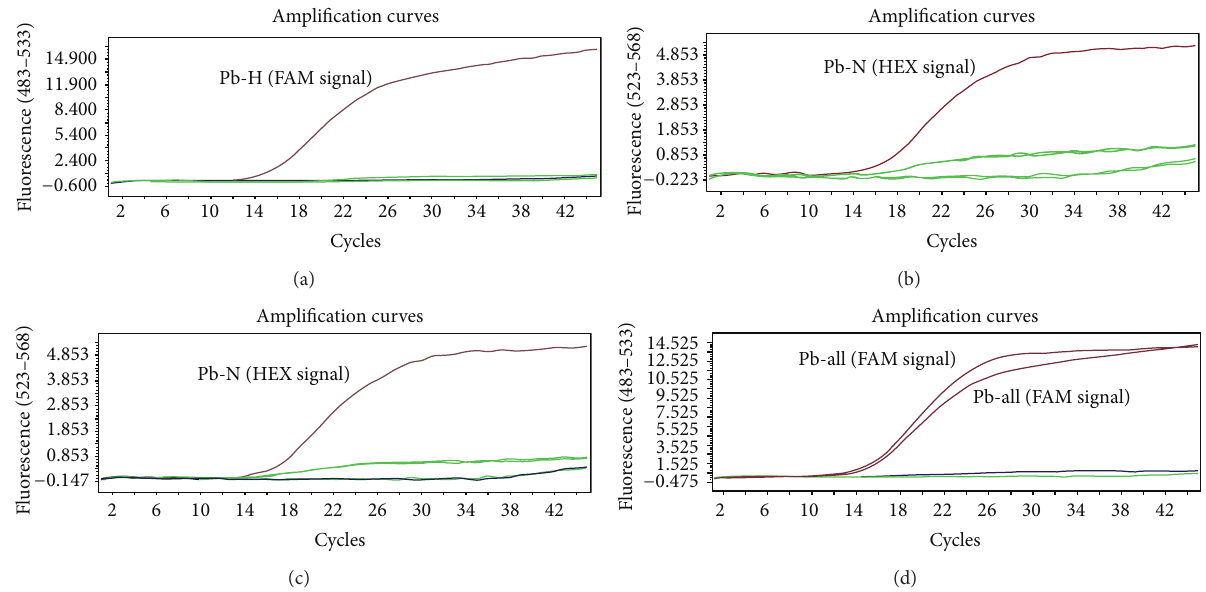
Figure 4: Specific amplification curves by duplex TaqMan probe real-time PCR. When Pb-H (FAM) and Pb-N (HEX) probes were combined in a duplex real-time PCR system, only the FAM fluorescent signal could be observed when the template was GD HP-PRRSV strain, no FAM signal was detected when the templates were CH-1a PRRSV strain and other viruses (a), and vice versa, only the HEX signal could be collected when the template was CH-1a PRRSV strain (b). When Pb-N (HEX) and Pb-all (FAM) were combined in a duplex real-time PCR system, the Pb-N (HEX signal) probe could only detect PRRSV strain (c), whereas Pb-all (FAM signal) probe could detect both HP-PRRSV and PRRSV strains